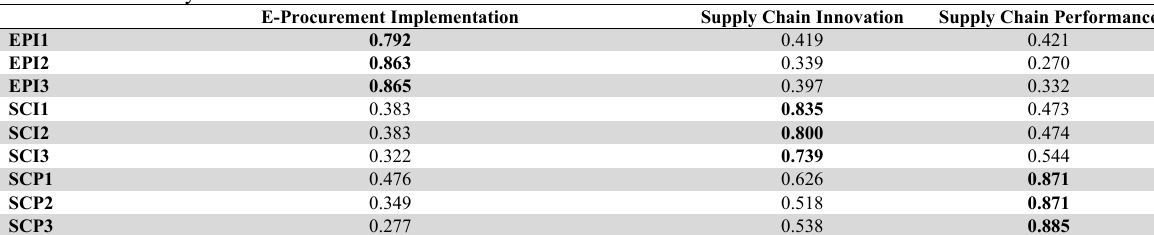
Discriminant validity